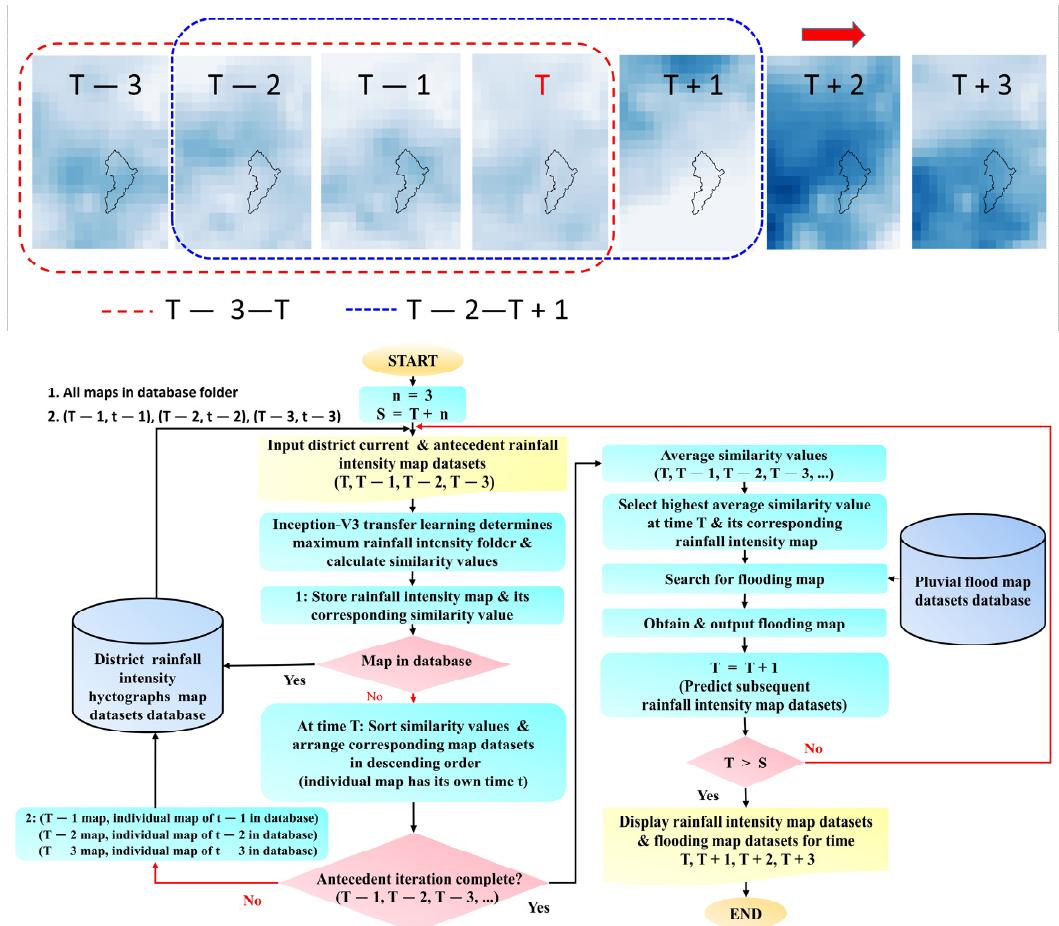
Figure 7. Rainfall map datasets and flooding map datasets developing, analyzing and predicting processes via Artificial Intelligence (AI) platform.